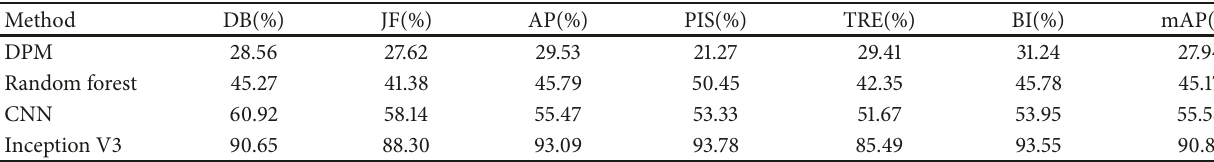
Table 2: Experimental